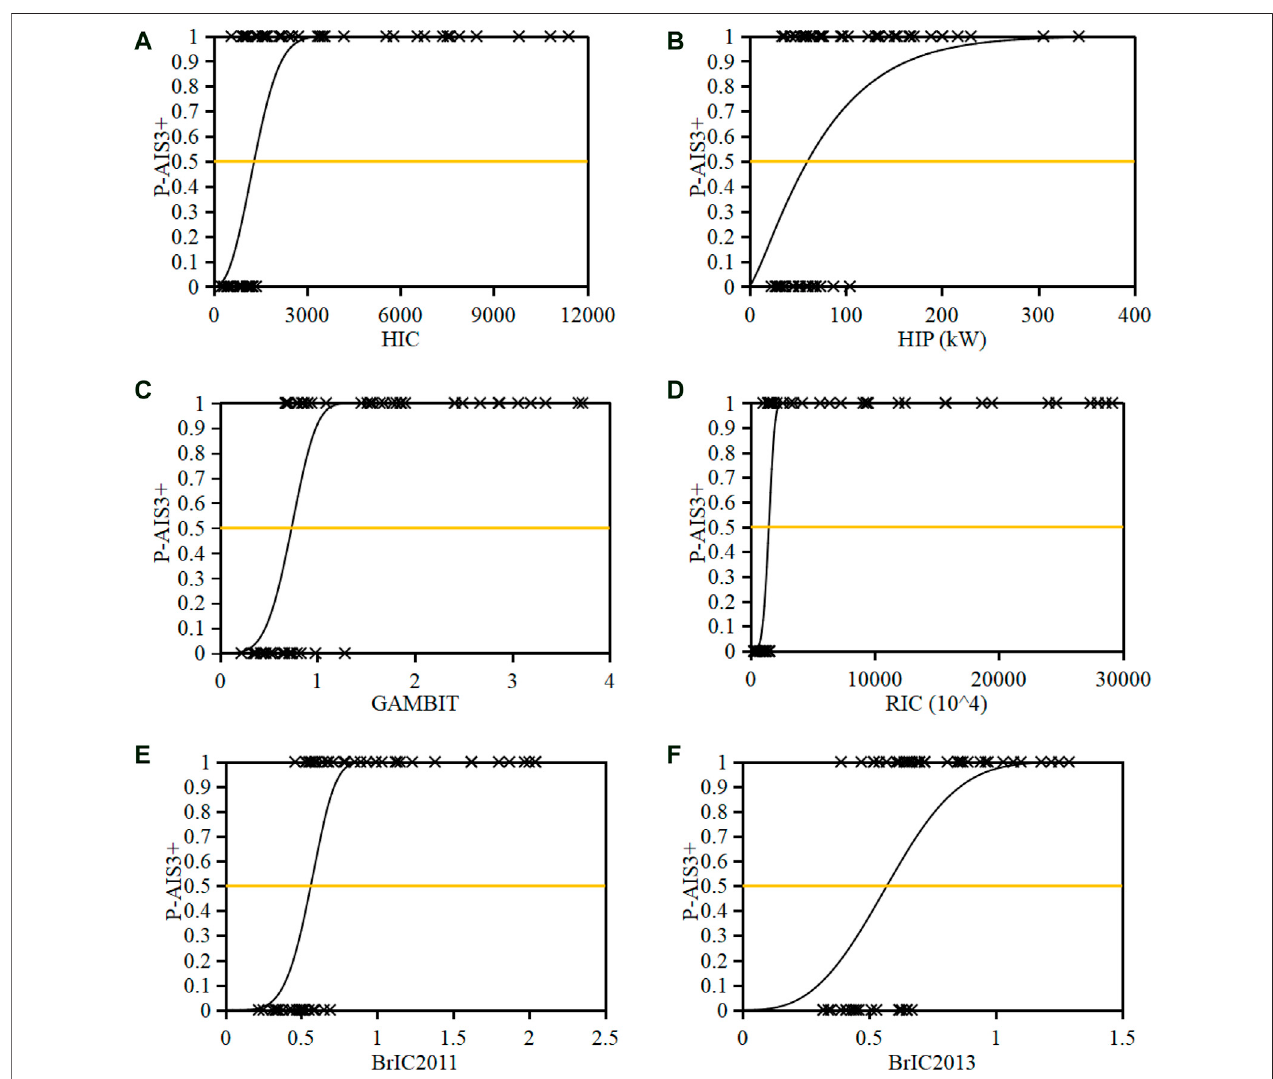
FIGURE 13 | Pedestrian head AIS3+ injury risk as functions of HIC (A) , HIP (B) , GAMBIT (C) , RIC (D) , and BrIC (E – F) .